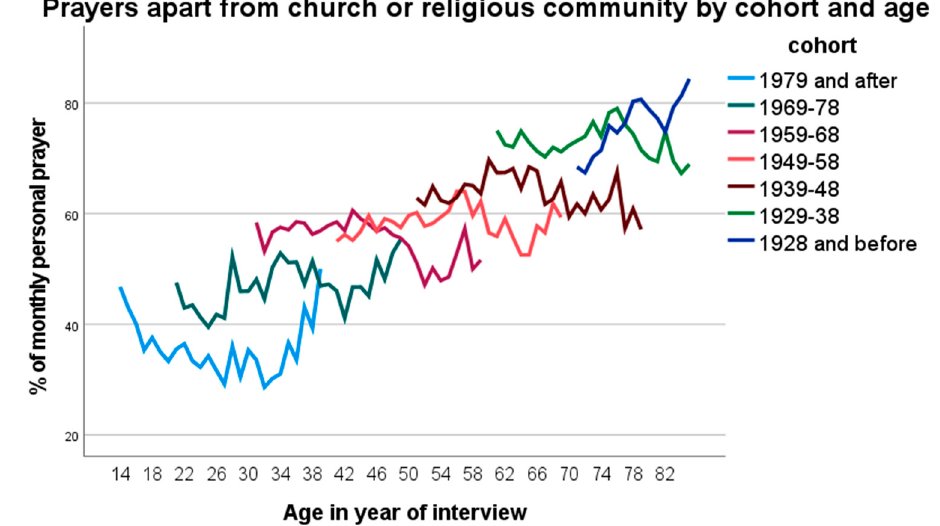
Figure 5. Proportion of prayers apart from church or religious community by cohort and age.